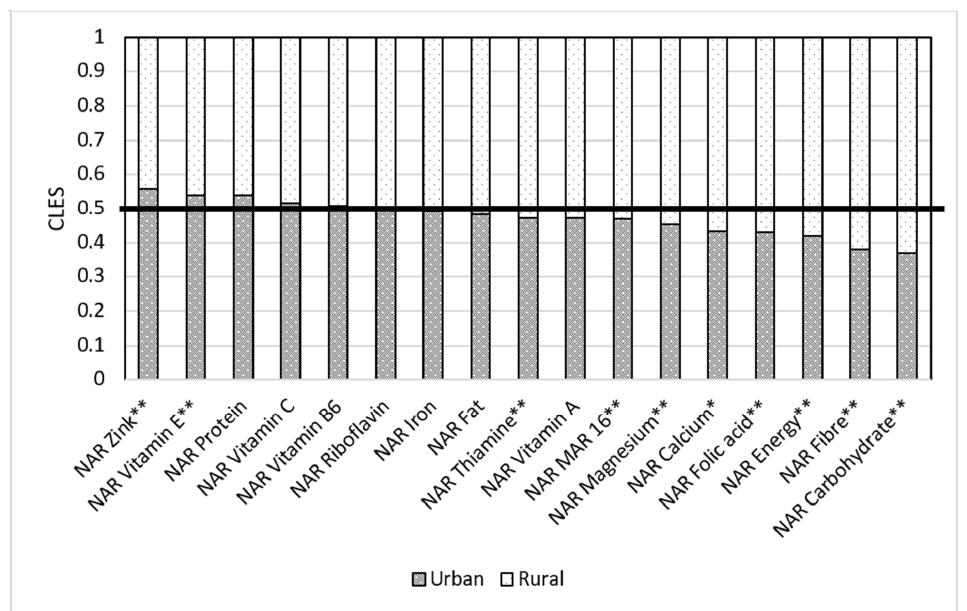
Figure 8. Comparison of NAR for 16 nutrients with urban and rural areas. NAR—nutrient adequacy ratio; Mar-16—mean nutrient adequacy ratio for 16 nutrients; CLES—common language effect size;